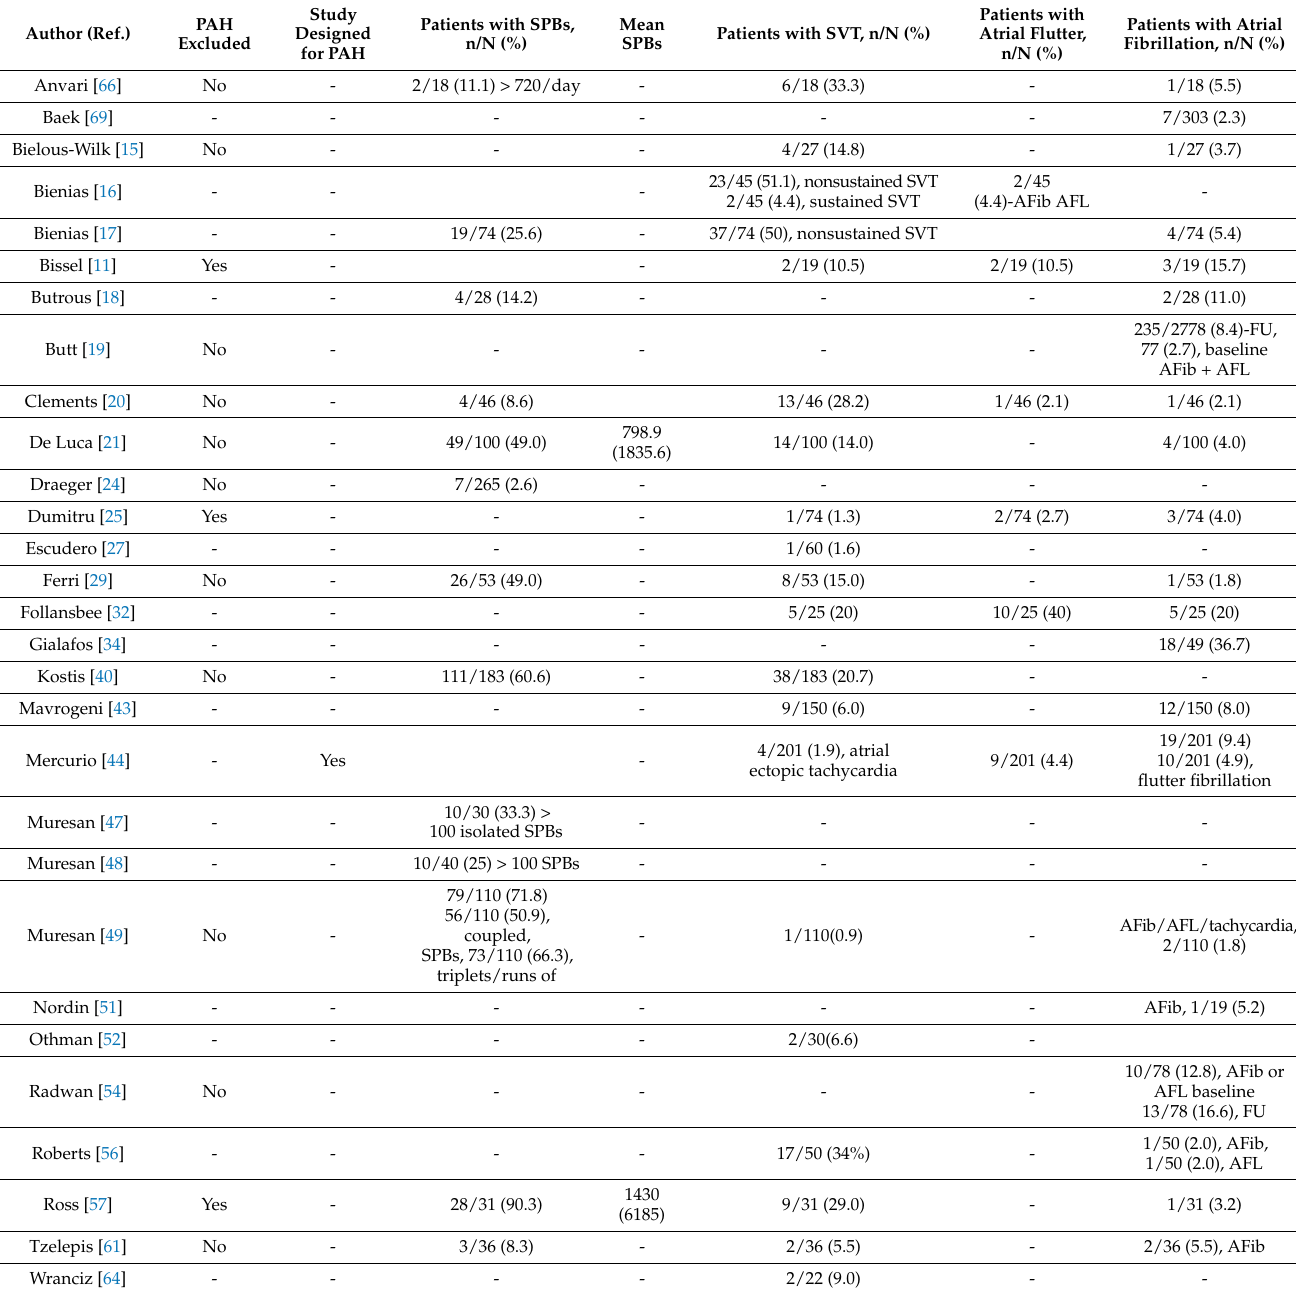
Table 3. Frequency of atrial arrhythmias in SSc